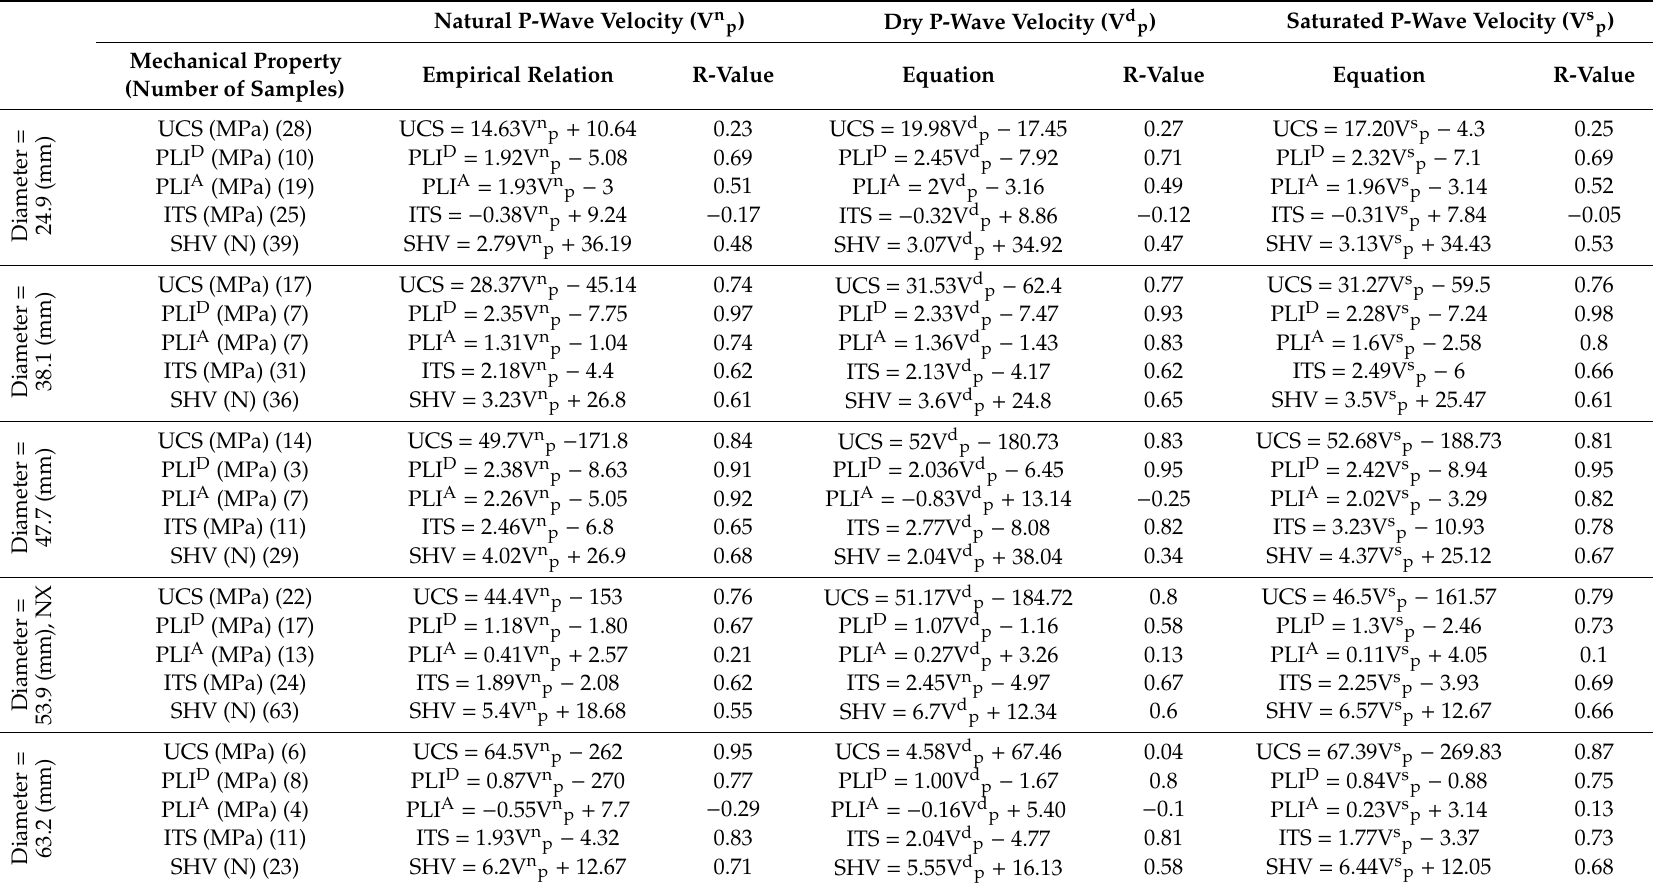
Table 1. Representative empirical relation and correlation coe ffi cient values of mechanical properties and natural, dry, and saturated P-wave velocities of limestone samples with various